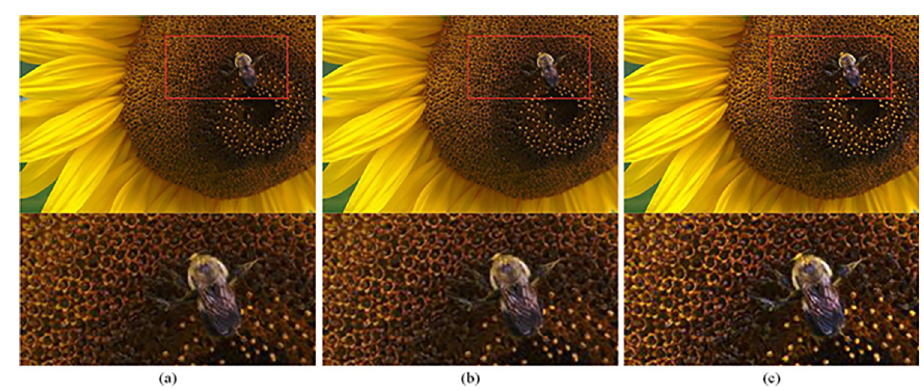
Fig 10. Image texture adding effect comparison. (a) Image processed by DHEDAPL (b) Image processed by DHEDAPL adding unsharp mask (c) Image processed by DHEDAPL adding texture mask.